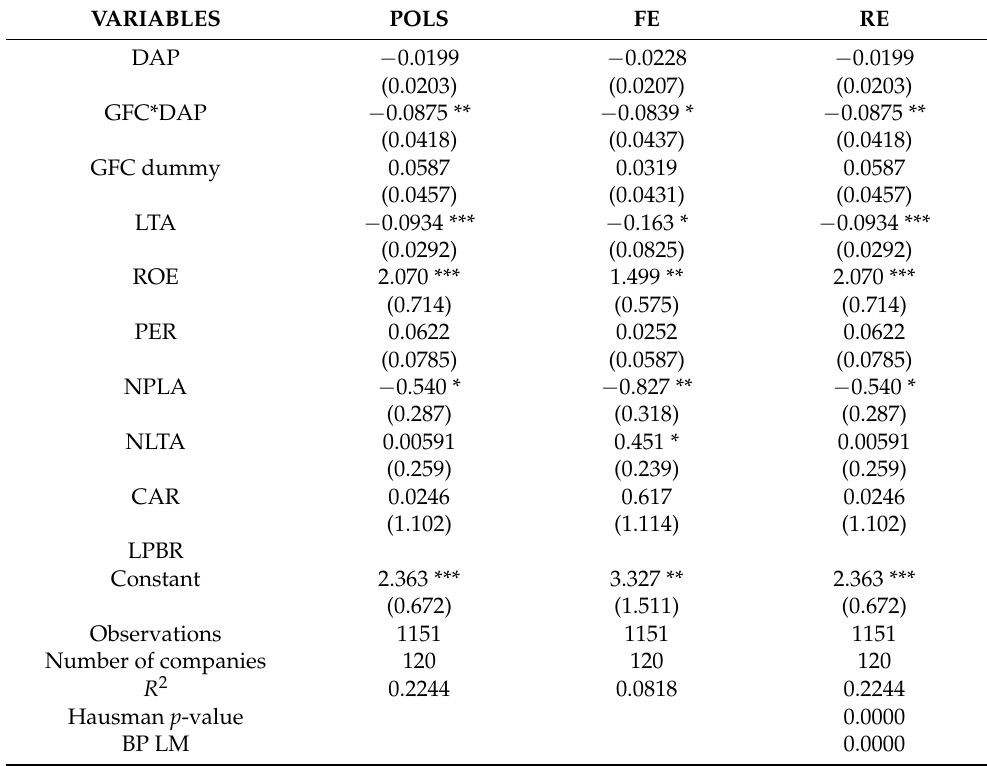
Table A3. Results of the regressions, considering the financial crisis period, when using other